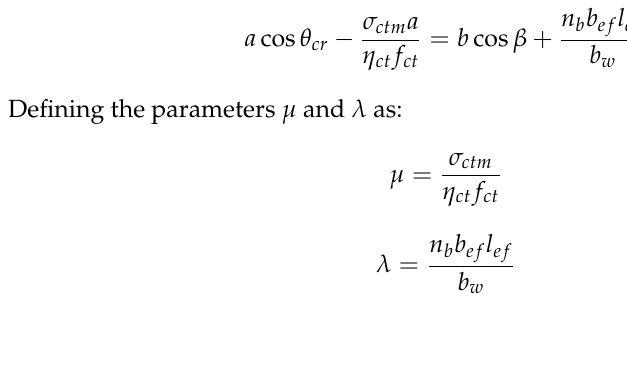
Figure 10. Details of cracked concrete with splitting crack.